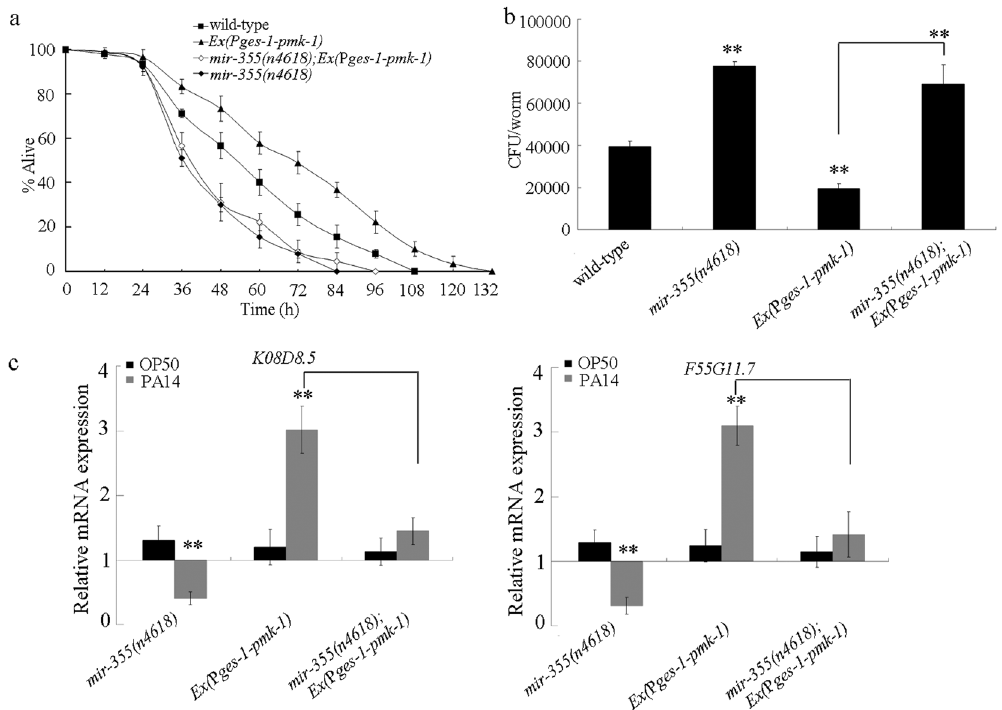
Figure 7. Genetic interaction between mir-355 and PMK-1 in the regulation of innate immune response to P. aeruginosa PA14 infection. ( a ) Genetic interaction between mir-355 and PMK-1 in the regulation of survival in P. aeruginosa PA14 infected nematodes. Statistical comparisons of the survival plots indicate that, after P. aeruginosa PA14 infection, the survival of mir-355(n4618);Ex( P ges-1-pmk-1) was significantly different from that of Ex( P ges-1-pmk-1) ( P < 0.001). Bars represent mean ± SD. ( b ) Genetic interaction between mir-355